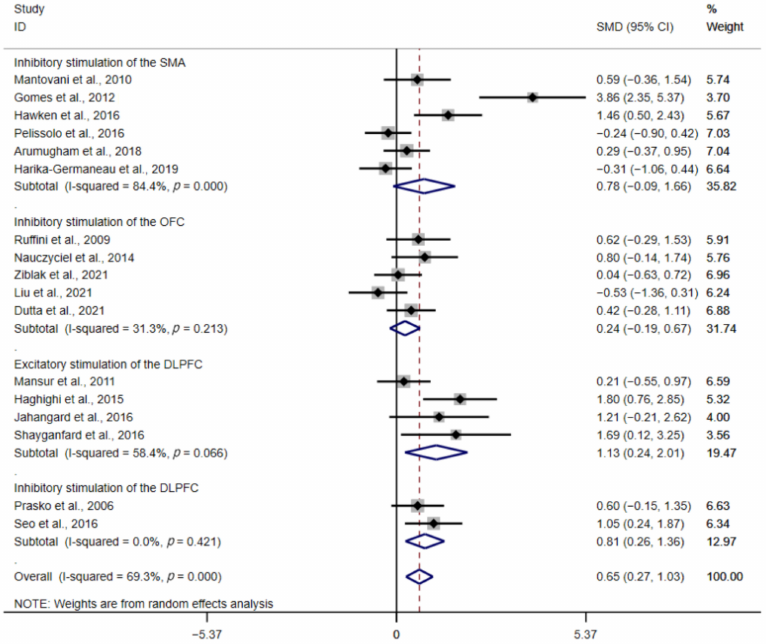
Figure 5. Forest plot of different stimulation protocols [23,26–36,38,40–43].